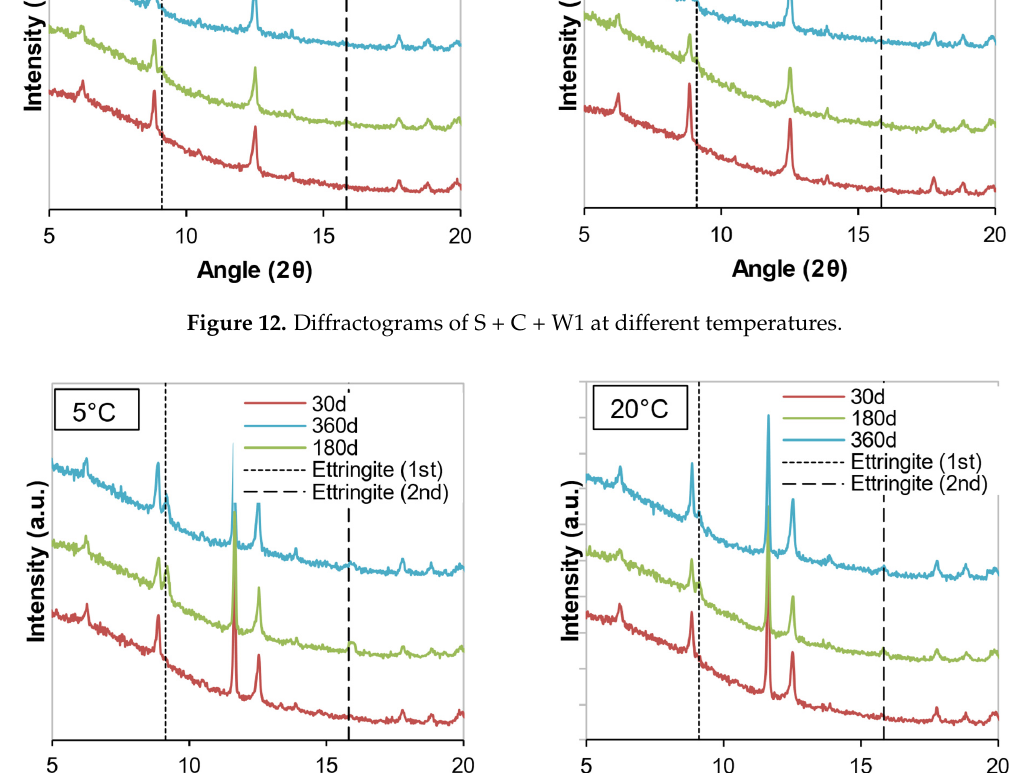
Figure 15. Diffractograms of S + F + W1 at different temperatures.